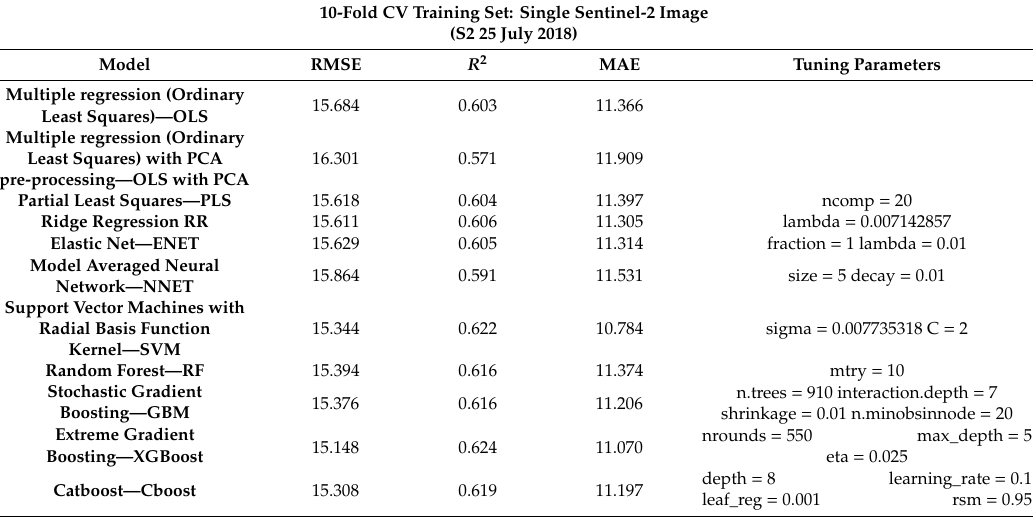
Table 3. The results of 10-fold cross-validation (CV) on the training set using a single S-2 image. RMSE, root-mean-square error; MAE, mean absolute error.